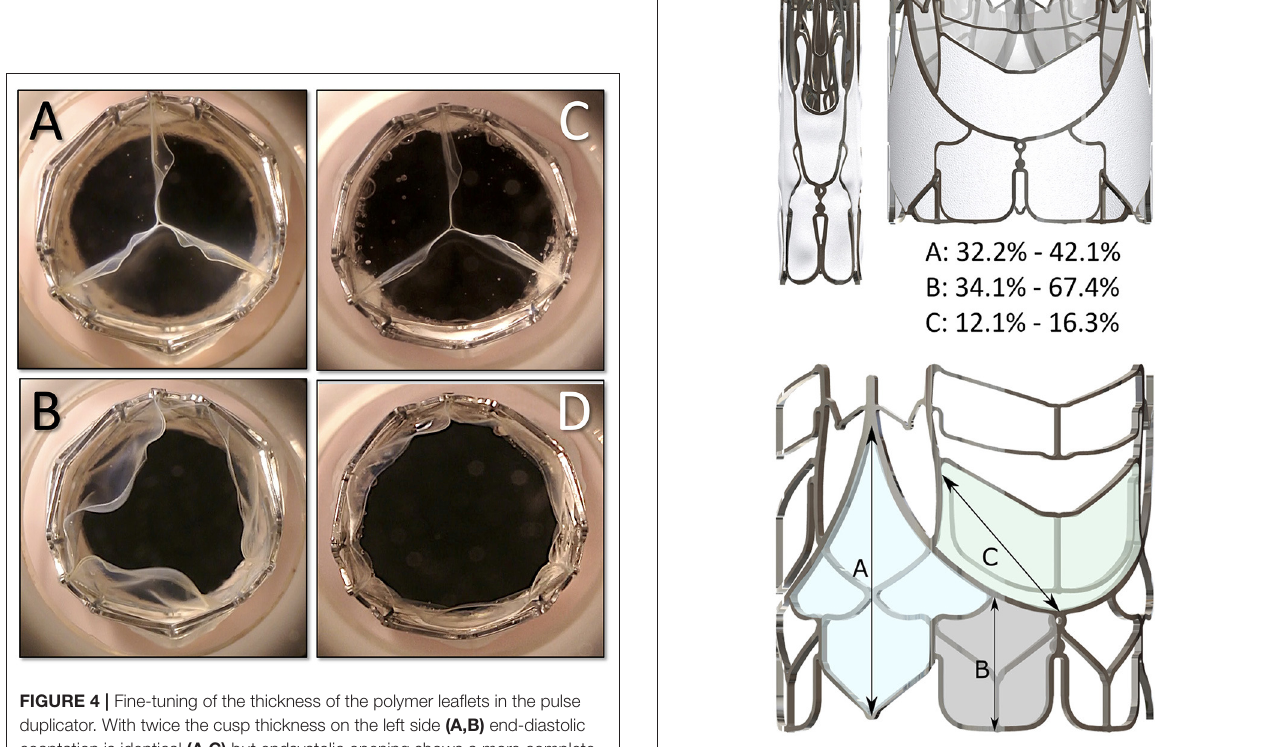
FIGURE 5 | Crimping of a scalloped stent leads to distinct elongations of the skirt. Stretching is most pronounced along the indicated vectors (A) at the commissures; (B) at the infra-annular flare and (C) on the supra-annular